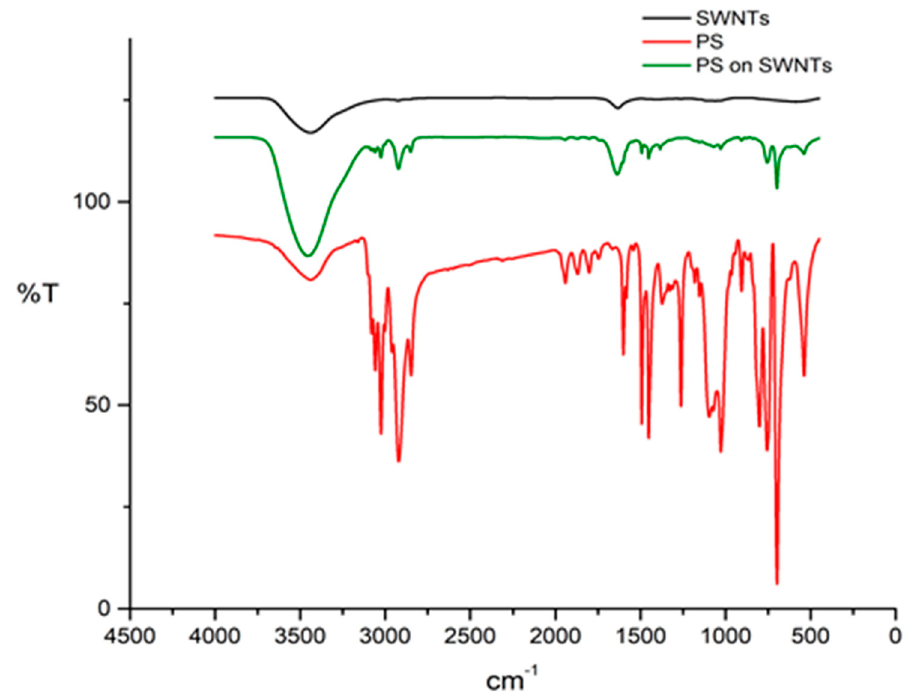
Figure 5. FT-IR spectrum of pristine SWNTs, PS, and PS- g -SWNTs.